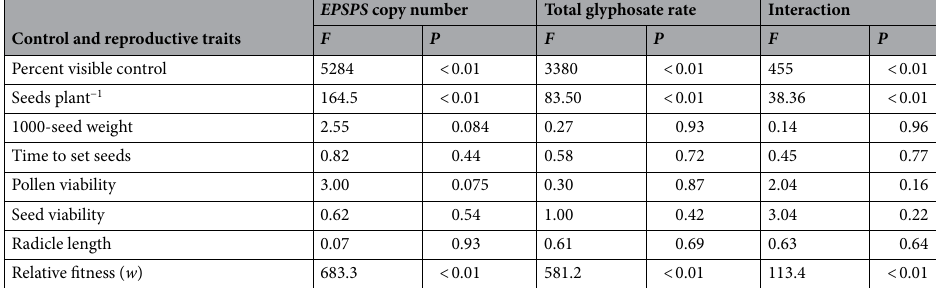
Table 2. F statistics and P values for the effects of EPSPS gene copy number (2–4, 5–6, and ≥ 8 EPSPS gene copies), total glyphosate rate (870, 1265, 1740, 2214, 3084, and 3954 g ae ha −1 applied as single or sequential applications), and their interactions on percent visible control, reproductive traits, and relative fitness of glyphosate-resistant Bassia scoparia plants in the field averaged across 2 years at the Montana State University Southern Agricultural Research Center near Huntley, MT, USA.